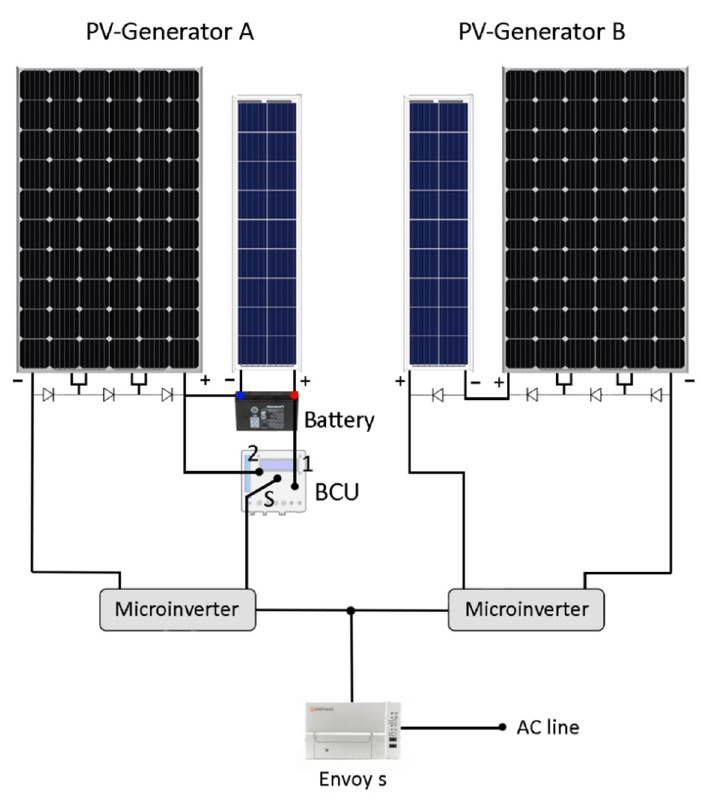
Figure 4. Schematic of the prototypal PV generator equipped with the Battery and the BCU.